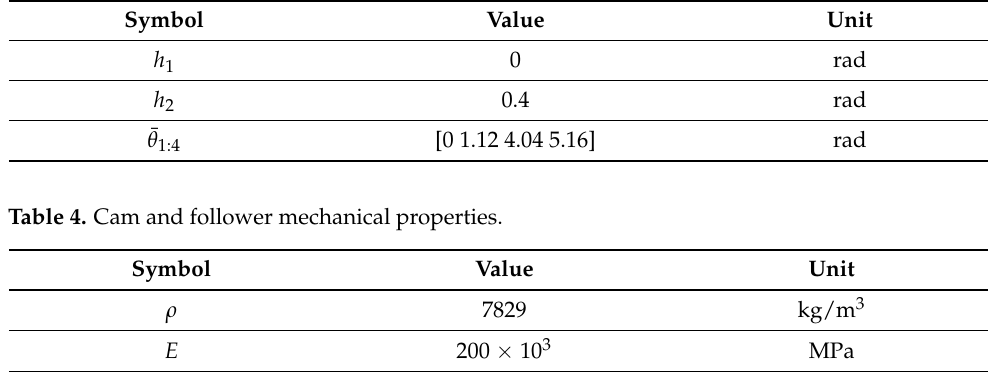
Table 3. Reference follower law parameters.